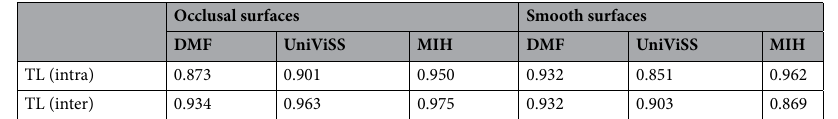
Table 1. Results from the calibration phase for inter- and intraexaminer reproducibility (unweighted kappa values).